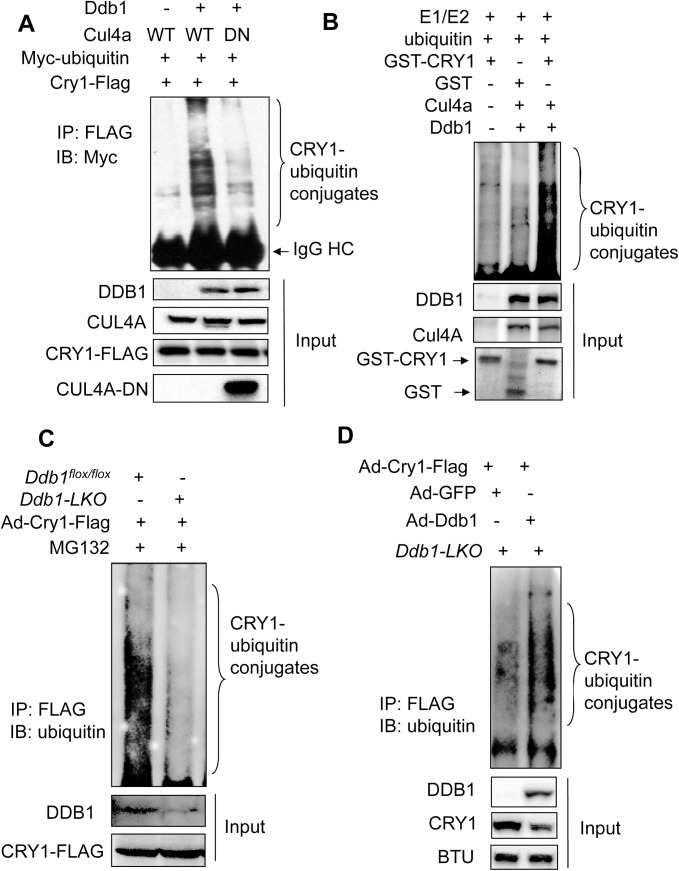
Cul4A-DDB1 E3 ligase promotes CRY1 ubiquitination both in vivo and in vitro.(A) Enhanced CRY1 ubiquitination in the presence of CUL4A-DDB1 E3 ligase. 293T cells were co-transfected with Cry1-Flag and Myc-ubiquitin in the presence of GFP, HA-Cul4A plus T7-Ddb1, or HA-Cul4A-DN plus T7-Ddb1. 24 hr after transfection, cells were treated with proteasome inhibitor MG132 (5 μM) for 16 hr and then harvested for detection of CRY1 ubiquitination. The protein levels of CRY1, CUL4A, DDB1 and DN-CUL4A in the whole cell lysates were determined by immunoblotting with specific antibodies. All the experiments were repeated at least three times and a representative result was shown here. (B) In vitro CRY1 ubiquitination by CUL4A-DDB1 E3 ligase. The purified GST-CRY1 fusion protein was mixed with the DDB1-CUL4A complex isolated from adenovirus-transduced 293T cells in the presence of E2, E3, and ubiquitin at 37°C for 2 hr before immunoblotting with anti-ubiquitin. GST-CRY1 and GST control were shown by Coomassie blue staining.(C) Reduced CRY1 ubiquitination in Ddb1-LKO primary mouse hepatocytes. After isolation from either 8-wk old Ddb1
flox/flox or Ddb1-LKO mice, primary mouse hepatocytes were transduced with Ad-Cry1-Flag for 24 hr and treated with MG132 (5 μM) for 16 hr before harvest. The protein lysates were subjected to denaturing IP to detect CRY1 ubiquitination. The protein levels of CRY1 and DDB1 in the whole cell lysates were measured by immunoblotting with either anti-FLAG or anti-DDB1. All the experiments were repeated three times and the representative result was shown here. (D) Adenoviral overexpression of Ddb1 rescues CRY1 ubiquitination in Ddb1-LKO primary mouse hepatocytes. Primary mouse hepatocytes were isolated from Ddb1-LKO mice and transduced by Ad-Cry1 along with either Ad-GFP or Ad-Ddb1. 24 hr post-transduction, cells were treated with MG132 for 8 hr and then harvested for detecting CRY1-ubiquitination.